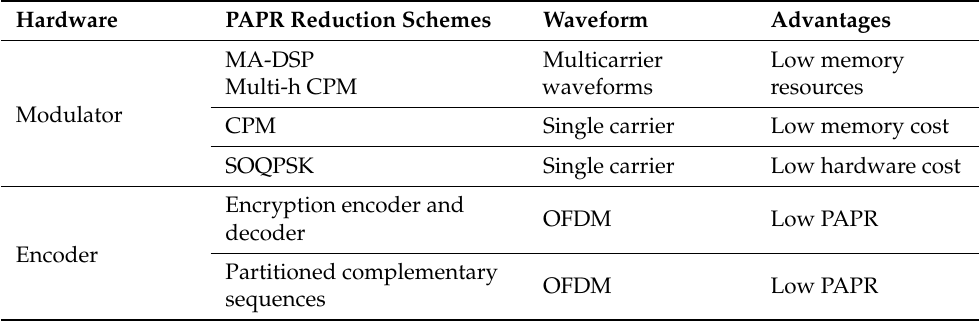
Table 2. Hardware design perspectives of different